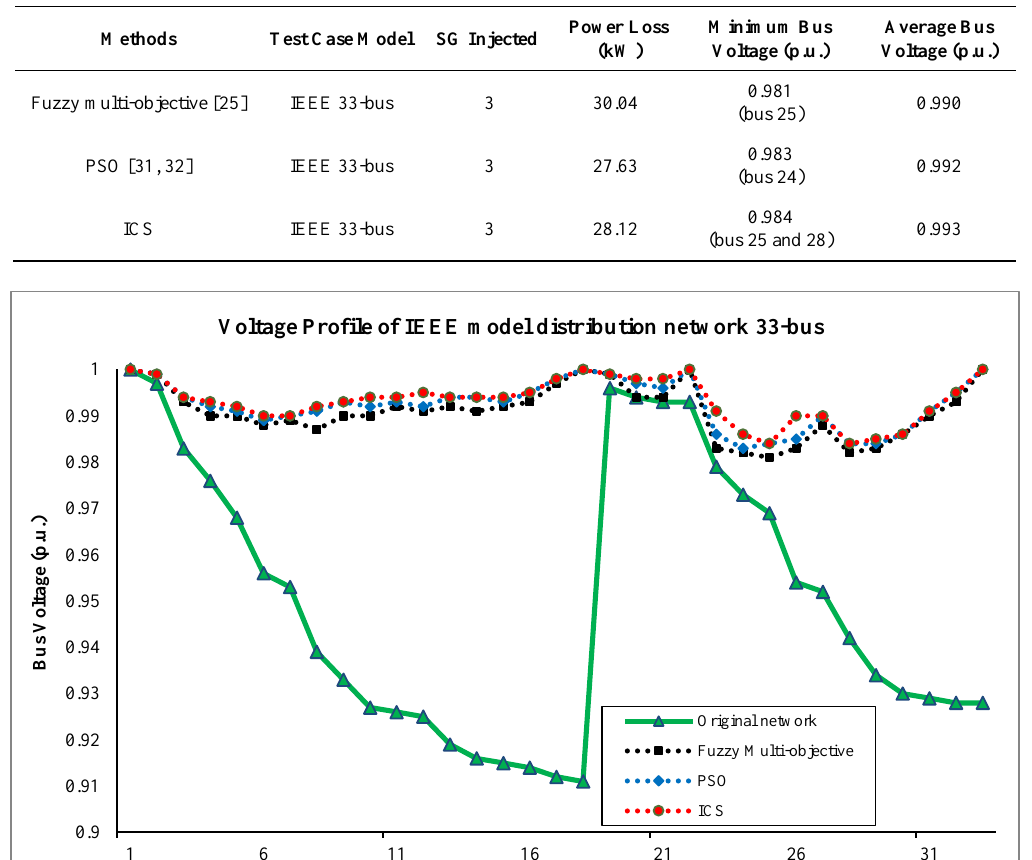
Table 3. Comparison of optimization results of proposed ICS method with fuzzy multi-objective and PSO methods.